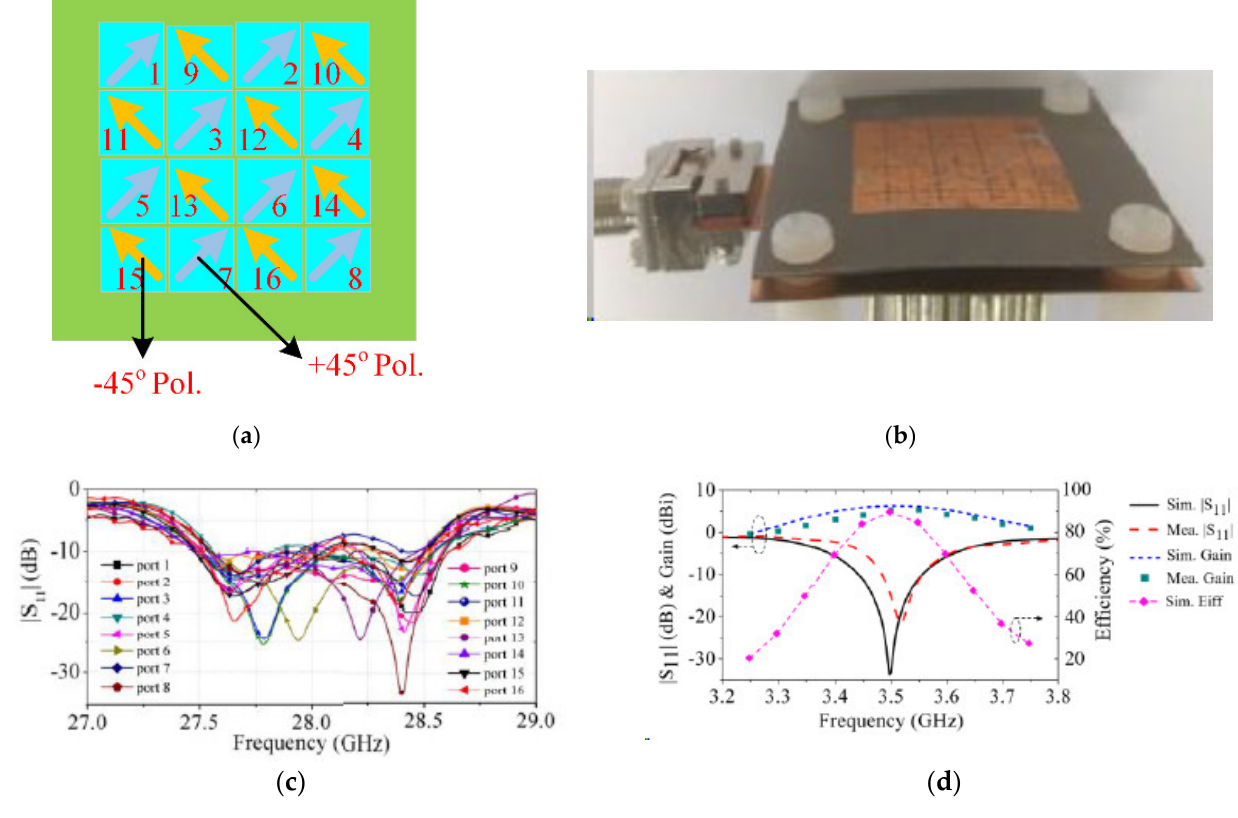
Figure 19. Configuration and results of the antenna from [97]: ( a ) antenna structure, ( b ) photo of the fabricated prototype ( c ) measured results at the mm − wave range, and ( d ) simulated and measured reflection coefficient and gain at the lower band. Table 4. Comparison between 5G antennas according to the operating frequency. Ref.